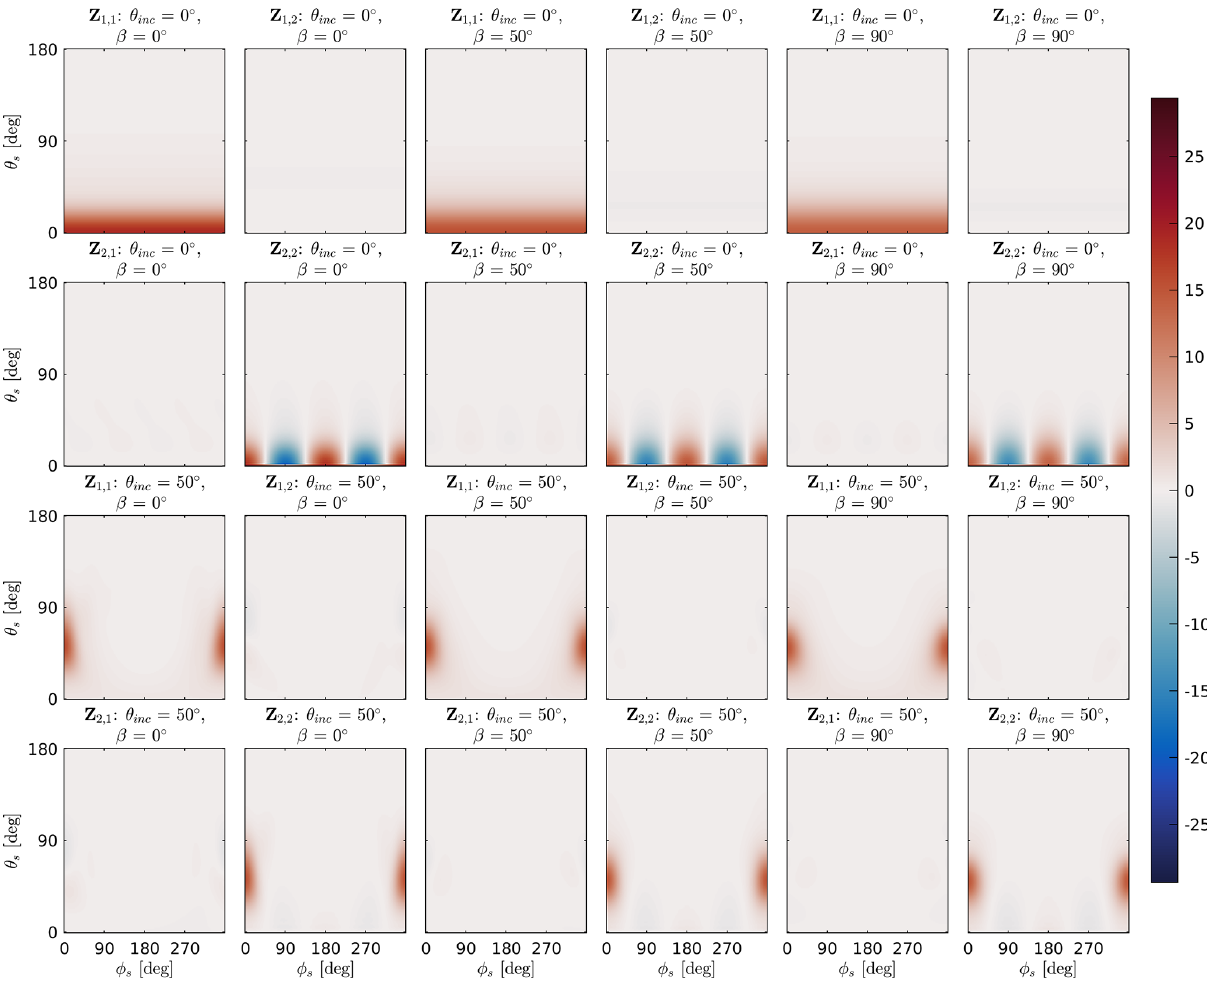
Figure 10. The upper-left block of the normalized scattering matrix ˆ Z of large plate aggregate with a volume-equivalent diameter of 427µm (Fig. 4) at 671GHz, as a function of the polar scattering angle θ s and the azimuth scattering angle φ s for a set of tilt angles β and incidence angles θ inc . A volume-equivalent diameter of 427µm at 671GHz corresponds to size parameter x ≈